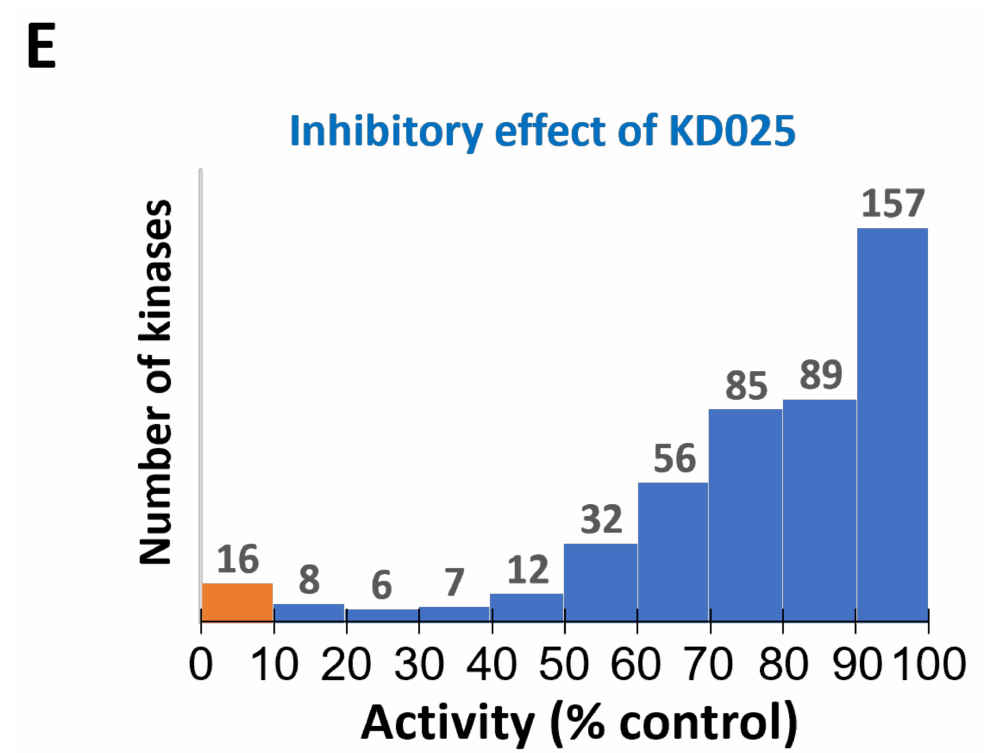
Figure 1. Kinome-wide target identification of KD025. Targets of KD025 (10 µ M) were screened against 468 recombinant human kinases (more than 80% coverage) by using the KINOMEscan TM screening platform. The experiment was performed in duplicate. ( A ) KD025 reduced kinase-ligand binding and the remained binding activity of kinases were plotted. Darker dots located near at the bottom indicate strong inhibition of KD025. Kinases were arranged in alphabetical order on the x-axis. ( B ) Top-ranked target kinases ≤ 10% ligand binding activity. ROCK2, the original target of KD025, showed the lowest activity remained (0.05%). ( C ) KD025–kinase interaction maps for 468 human kinases. Kinases binding with KD025 were marked by red circles; the larger the circles, the higher binding affinity with KD025. The kinase dendrogram was provided from KINOMEscan TM service. The name of kinases with high affinity (POC ≤ 10%) was marked near the corresponding circles. ( D ) Familial distributional pattern of kinase-ligand binding activity affected by KD025. Kinases were sub-grouped by kinase family and sorted by POC. AGC, atypical; CAMK, calcium/calmodulin-dependent kinases; CK1, casein kinase 1 family; CMGC; lipid; other; pathogen; STE; TK, nonreceptor tyrosine kinases; TKL, tyrosine kinase-like kinases. ( E ) Histogram of KD025-kinase binding. X-axis indicates remained kinase-ligand binding activity, and y-axis shows the number of kinases belonging to each bin. Bin size =